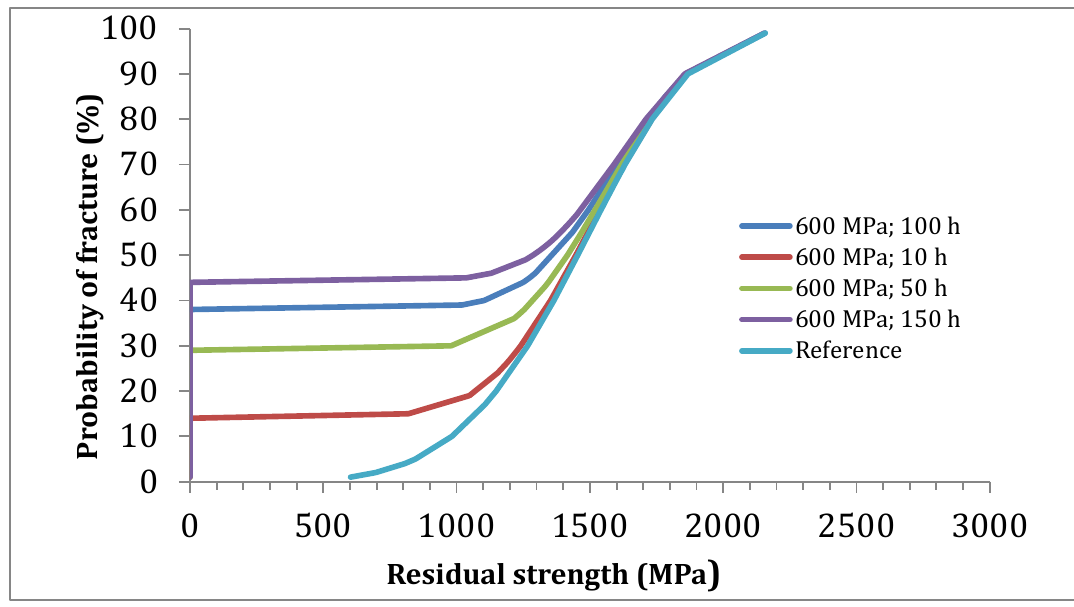
Figure 10. Prediction of the evolution of total distributions of residual strengths for various durations of static fatigue tests under the constant stress of 600 MPa.